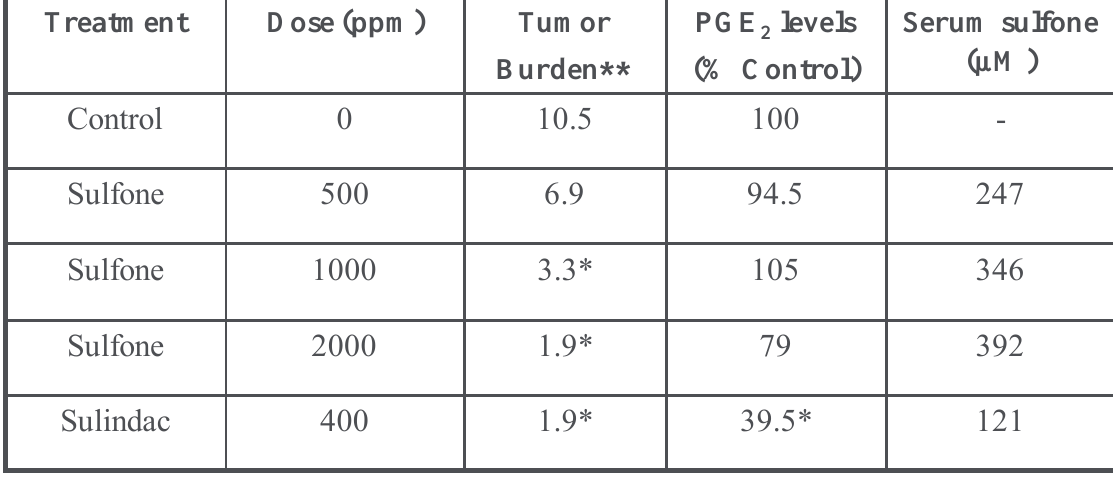
Table 2. Inhibition of colon tumorigenesis in rats by sulindac sulfone and sulindac.